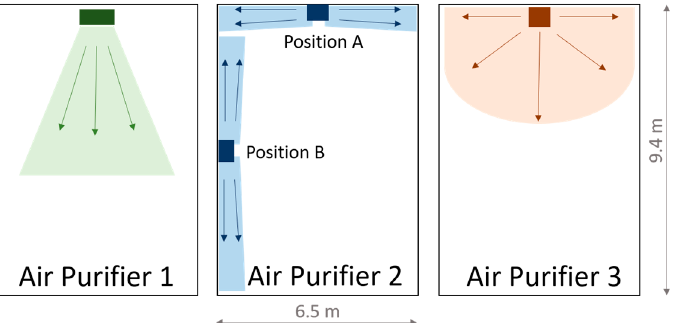
Figure 1. Illustration of the installation position of the three different APs used including the qualitative flow at the outlet. AP 2 was examined individually at two different locations (A and B).